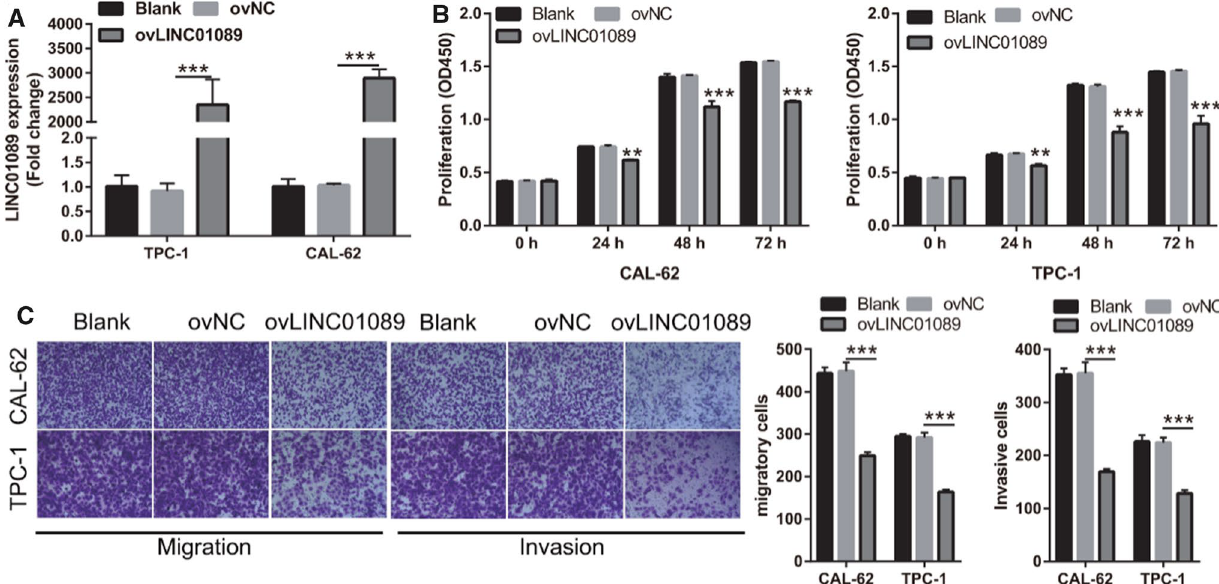
Fig. 2 LINC01089 inhibits proliferation, migration, and invasion capacity of thyroid cancer. A LINC01089 expression in blank, ovNC-trans- fected, and ovLINC01089-transfected TPC-1 and CAL-62 cells was measured by RT-qPCR at 48 h after transfection. B The proliferation of TPC-1 and CAL-62 cells was evaluated by CCK-8 assay at 48 h after transfection. C Migration and invasion capacity of TPC-1 and CAL-62 cells were assessed by Transwell assay at 48 h after transfection (magnification, 100×). Histograms represent the mean ± SD (n = 3). **p < 0.01, ***p <